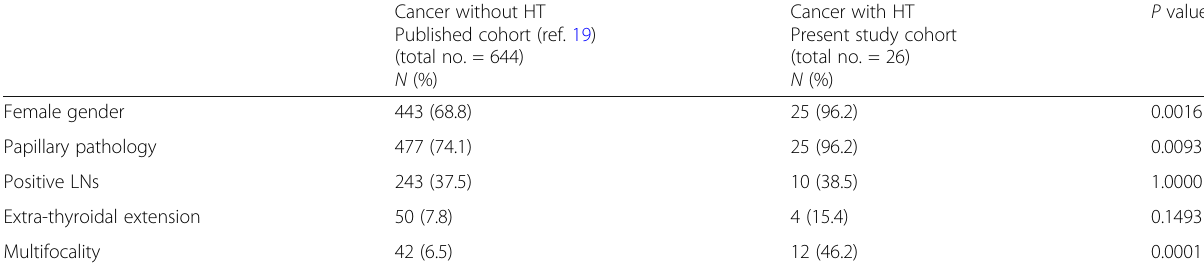
Table 1 Thyroid cancer with Hashimoto thyroiditis compared to thyroid cancer without HT Cancer without HT Published cohort (ref. 19)